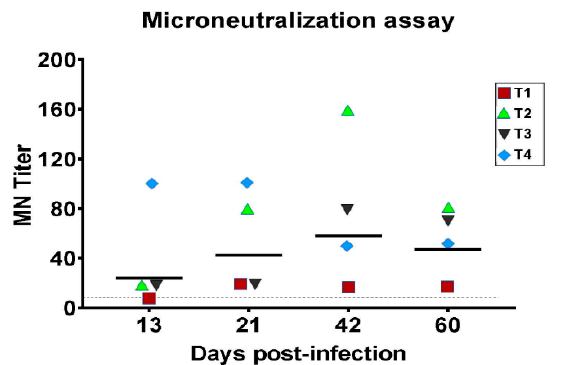
Figure 2. Seroconversion of D/CA2019 in horses. The D/CA2019 specific viral titers were determined by the MN assay using MDCK cells. Each shape represents an individual animal. The log-transformed values of individual antibody titers (GMT) are shown (T1: red square, T2: green triangle, T3: black inverted triangle, T4: blue diamond) with a horizontal geometric-mean bar shown at 13, 21, 42, and 60 dpi. A dotted line indicating the limit of detection is also shown.